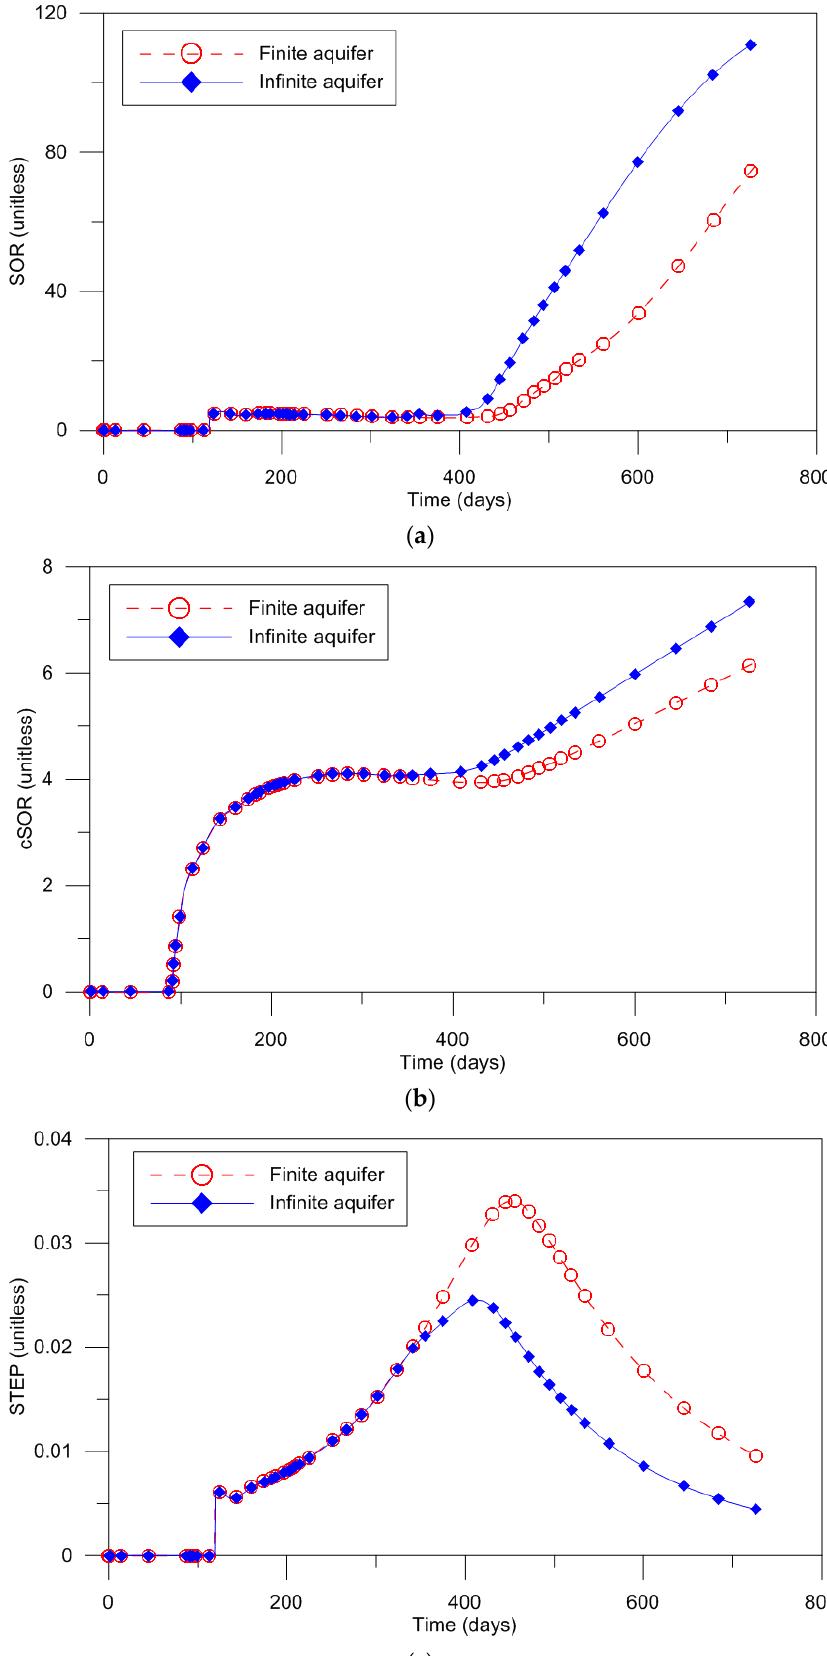
Figure 3. Comparison of energy efficiency with time: ( a ) steam to oil ratio ( SOR ); ( b ) cumulative steam to oil ratio ( cSOR ); and ( c ) simple thermal efficiency parameter ( STEP ).